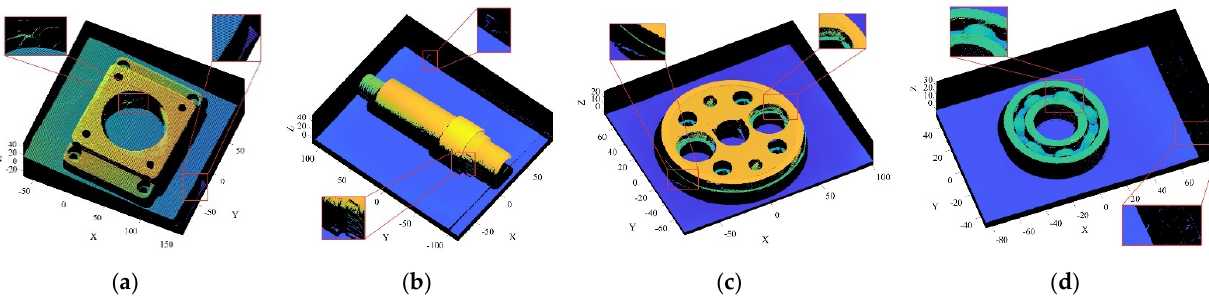
( d ) Figure 12. Denoising results for NLD algorithm: ( a ) object 1; ( b ) object 2; ( c ) object 3; ( d ) object 4.